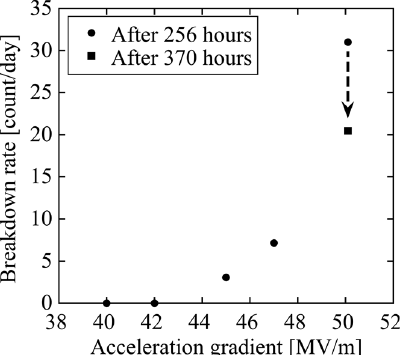
FIG. 11. Dark current emissions dependent on the acceleration gradients as the conditioning time changes. The plus signs, open crosses, open squares, open triangles, and solid circles corre- sponding to conditioning times of 103, 141, 193, 252 and 385 h after the start of conditioning, respectively.